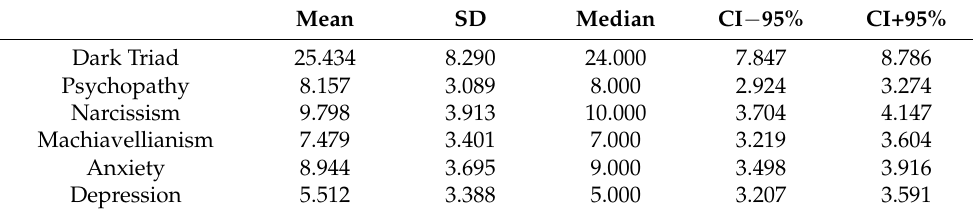
Table 2. Descriptive statistics of the